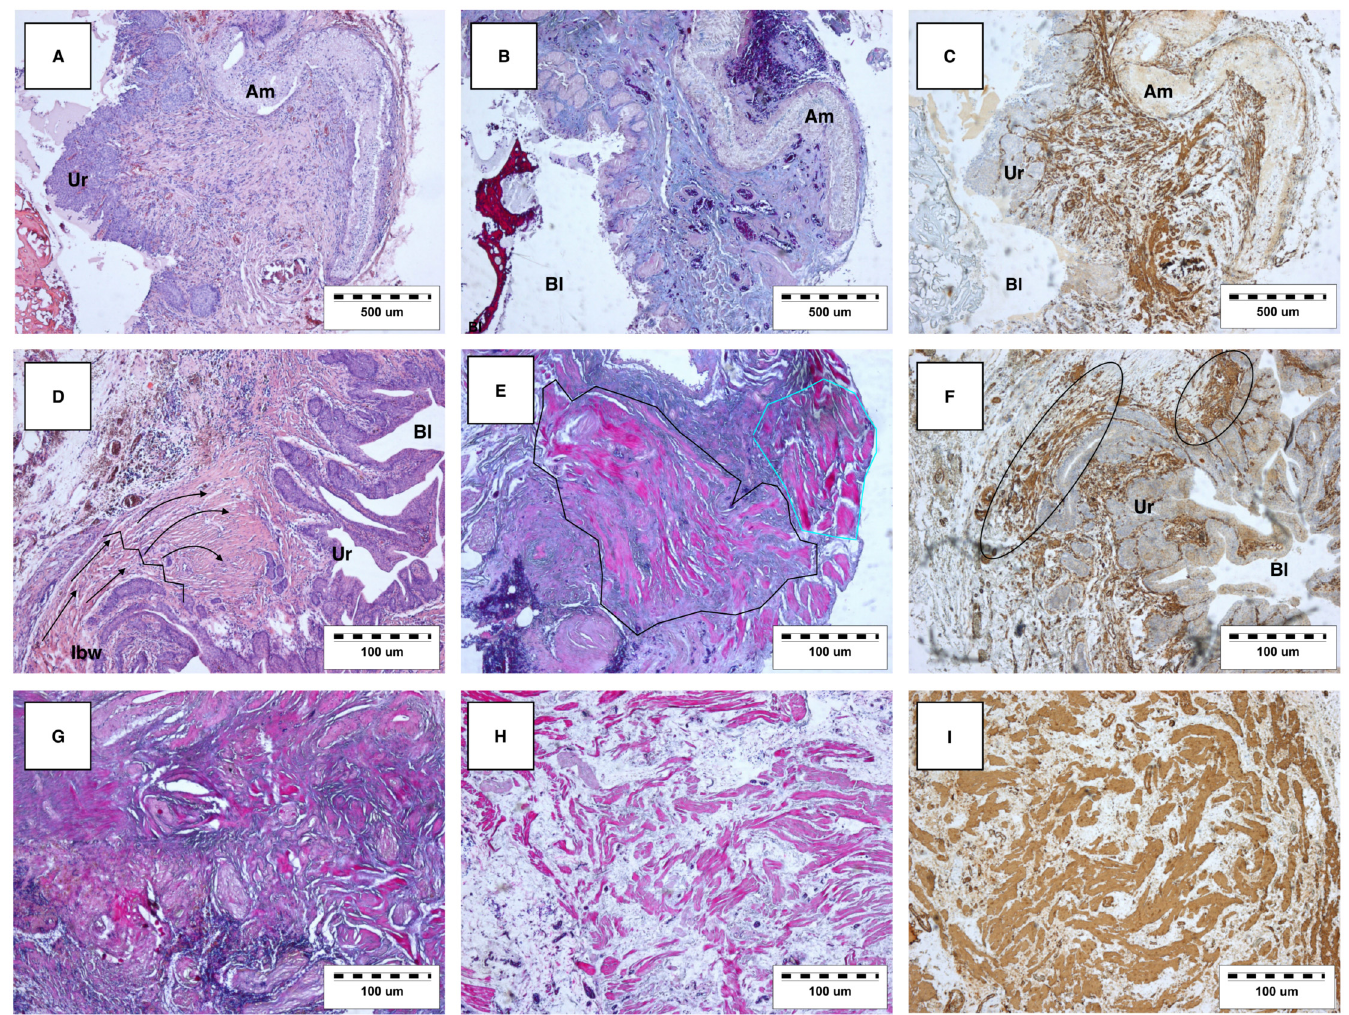
Fig 6. Histological and immunohistological analysis of the reconstructed urinary bladder wall. Am; Amniotic membrane, Ur; Urothelium, Bl; lumen of urinary bladder, IBW; Intact host urinary bladder wall. (A) H&E staining displaying mild inflammatory infiltration. (B) TRI displaying regenerating single muscle bundles from the central part of the reconstructed bladder wall. (C) Anti-smoothelin staining revealing frequently arranged smooth muscle bundles. Strong immunoreactivity beneath the urothelium layer is observed. (D) H&E staining revealing the border between the intact bladder wall and reconstructed bladder wall (zigzag line). The elongating smooth muscle cells (black arrows) gradually loose their layered architecture. Moderate inflammatory infiltration is also observed. (E) TRI displaying the regularly arranged smooth muscle bundles; some smooth muscle bundles run transversely (cyan line), but the most obvious bundles run longitudinally (black line). The specimen was obtained from the edge of the reconstructed bladder wall. (F) Anti-smoothelin staining displaying the distribution of smoothelin positive-cells (black ovals) under the urothelial layer. (G) TRI staining displaying the abundant disorganised hypertrophied smooth muscle bundles in the peripheral part of the reconstructed bladder wall. (H) TRI showing smooth muscle bundles separated by collagenous fibres in the central part of the reconstructed bladder wall. (I) Anti-smoothelin staining revealing abundant smoothelin expression in the peripheral part of the reconstructed bladder